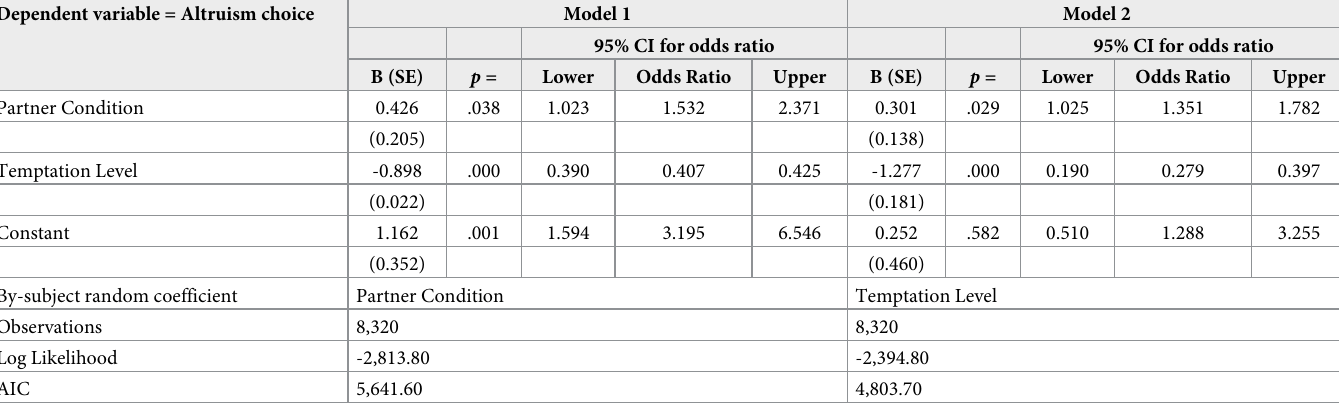
Table 1. Analysis results from Experiment 1 using mixed-effects logistic regressions of partner condition and temptation level on subject’s choices. Model 1 is used for inferring the effect of partner condition on altruism rates; it contains a by-subject random coefficient for this variable. Likewise, Model 2 is used for inferring the effect of temptation level on altruism rates; it contains a by-subject random coefficient for this variable.